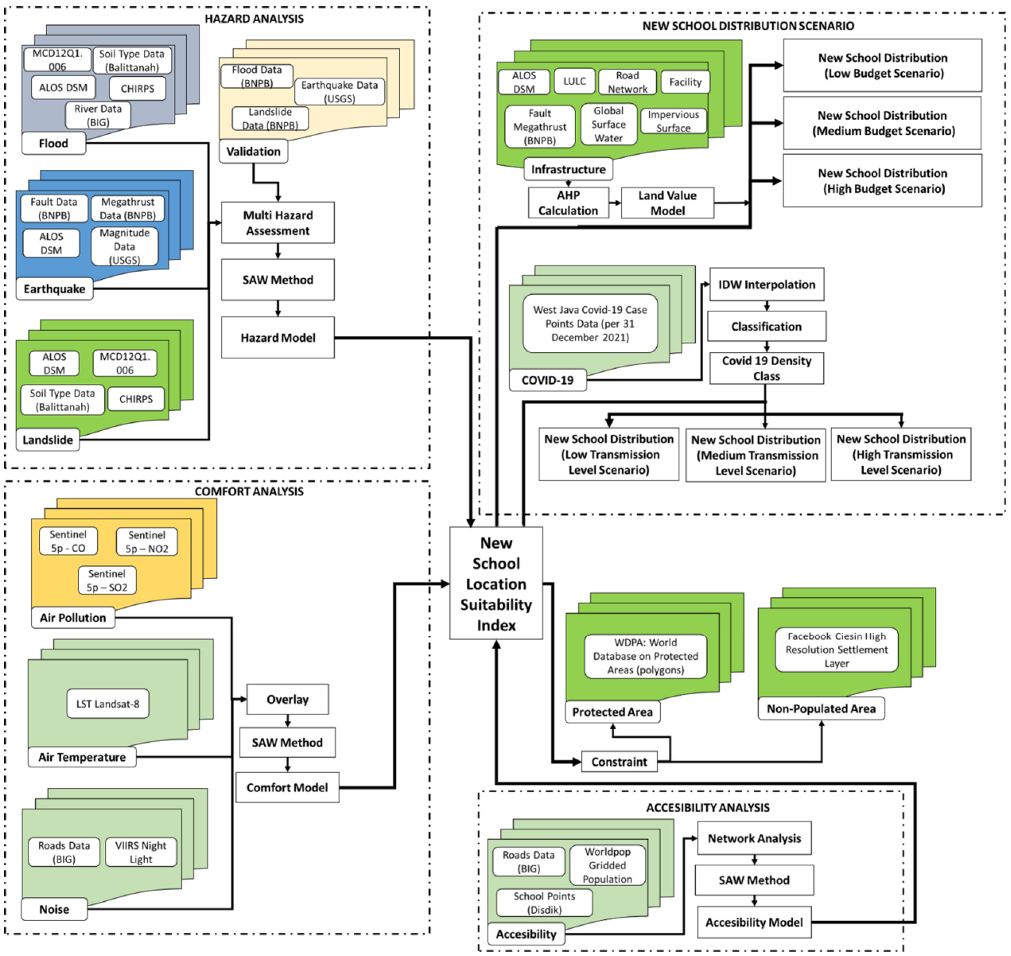
Figure 4. Flow chart of the methodology